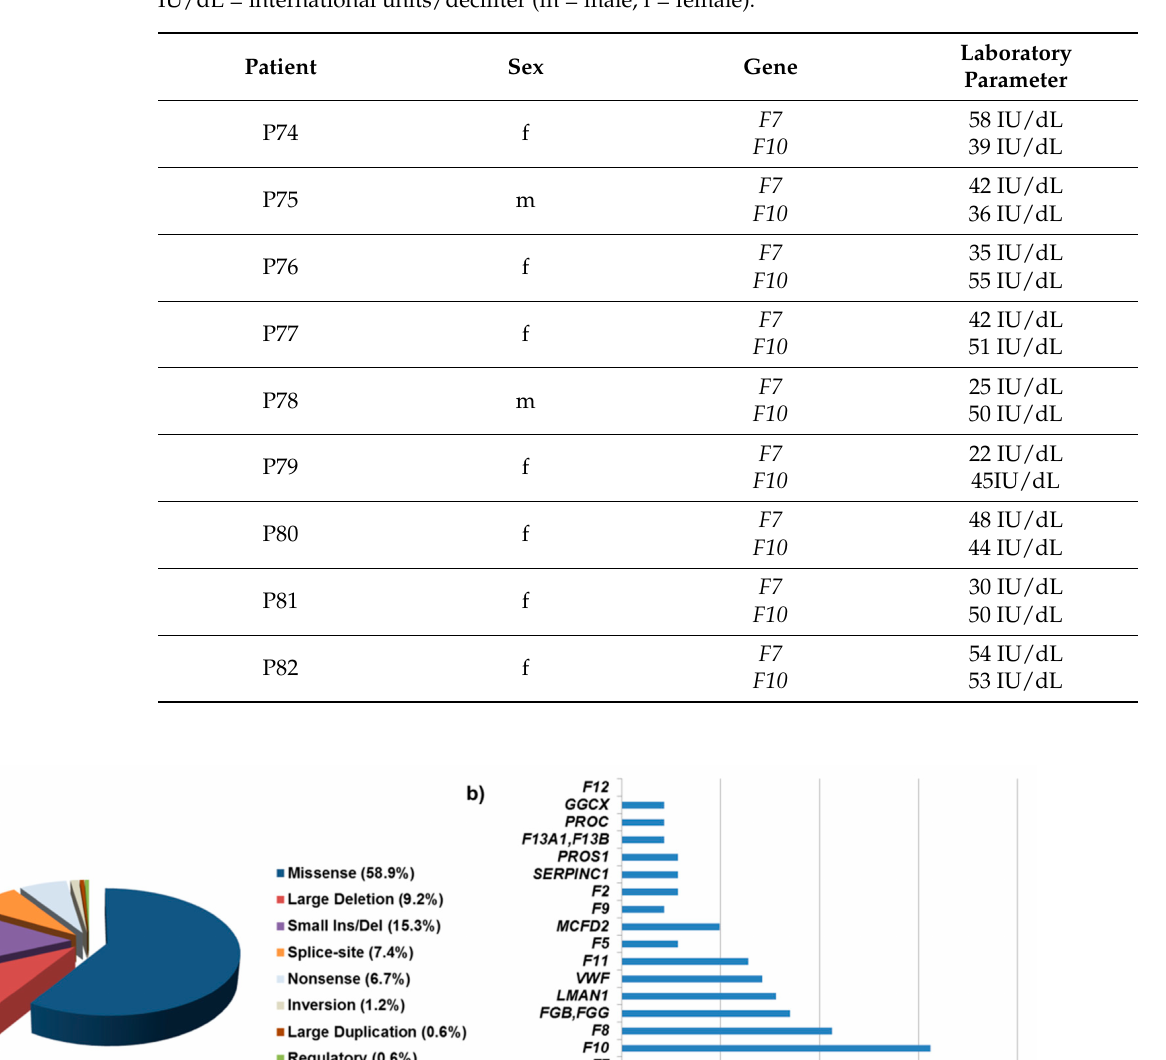
Table 3. Laboratory and genetic features of the FMCFDs arising from cytogenetic abnormalities IU/dL = international units/deciliter (m = male, f = female).